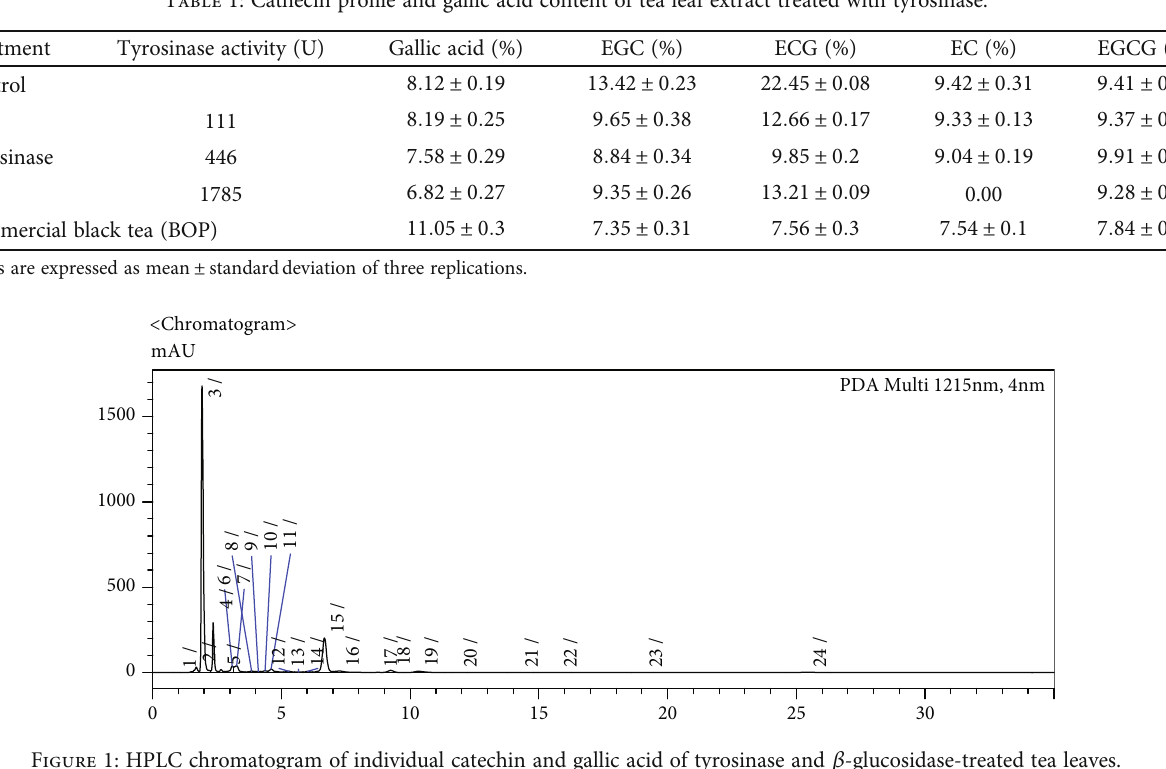
Table 1: Cathecin pro fi le and gallic acid content of tea leaf extract treated with tyrosinase. Treatment Tyrosinase activity (U) Control